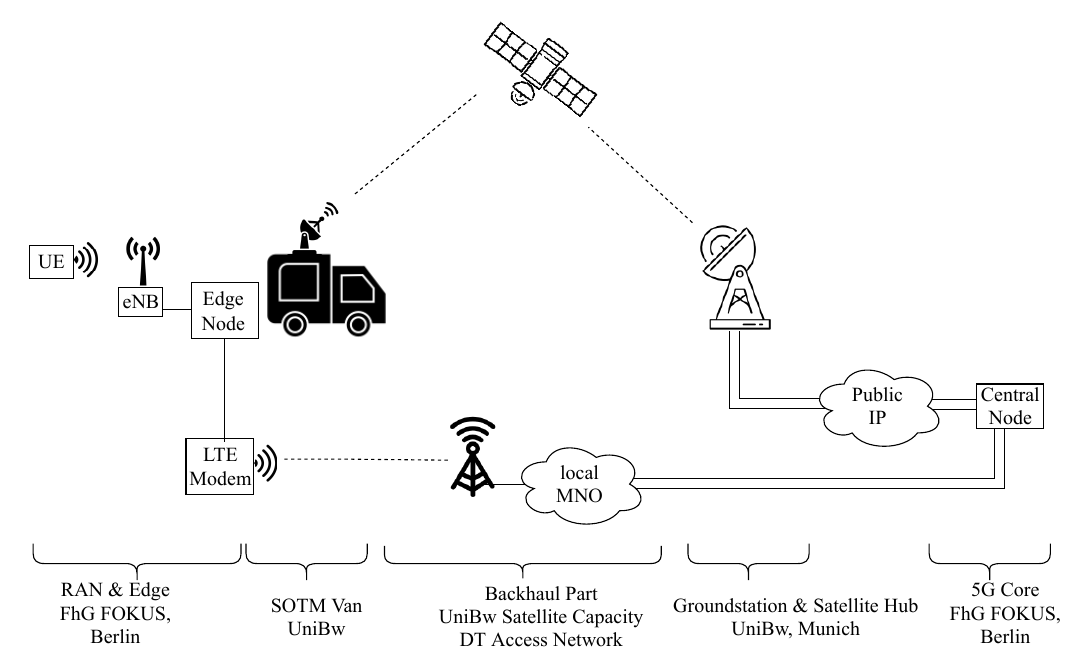
Figure 14. 5G connectivity on the move demo: SATis5 testbed demo architecture (Setup 2).